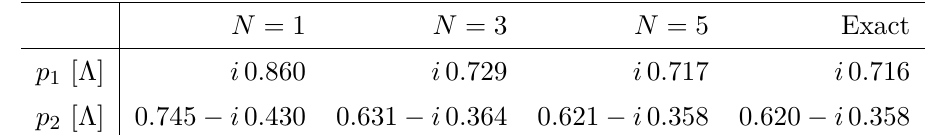
( p 2 ) 0; N which is not 2